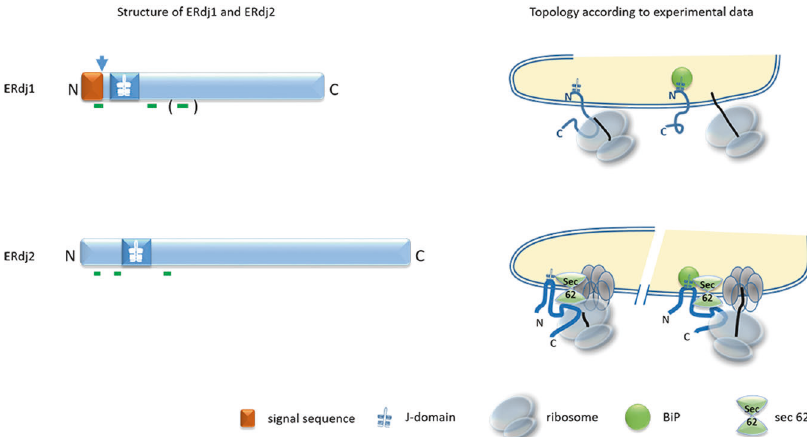
Fig. 1 Structure and topology of ERdj1 and ERdj2. Upper line: Computational analyses of the structure of ERdj1 predicts a cleavable signal peptide and three transmembrane domains (green lines). Green lines in brackets indicate that the existence of the transmembrane domain was not con fi rmed experimentally. The probability of signal sequence cleavage (arrow) of ERdj1 is calculated to be 97%. Experimental data show that the fi rst predicted transmembrane domain, which is located within the signal sequence, is cleaved upon translocation of ERdj1 into the ER. ERdj1 is anchored within the membrane of the endoplasmic reticulum by the second predicted transmembrane domain while the third predicted transmembrane domain is not used in vivo resulting in a cytosolically localized C-terminus, which interacts with the ribosome to inhibit the initiation of translation [9]. When the J-domain binds to BiP this inhibition is released and cotranslational translocation of speci fi c proteins proceeds [9, 12, 14]. Lower line: Computational analyses of ERdj2 predicts three transmembrane regions, the orientation is likewise possible with the C-terminus either intraluminal or cytosolic. No signal sequence is identi fi ed by computational programs. Experimental data con fi rm two of the predicted transmembrane domains resulting in a topology with the N- and C-terminus facing the cytosol and the J-domain being located in the lumen of the ER. The C-terminus of ERdj2 interacts with Sec62 and inhibits the translation of target proteins [18]. The J-domain of ERdj2 can bind to BiP in the presence of ATP and stimulate its ATPase activity [17] releasing the translational block at the ribosomal tunnel exit.